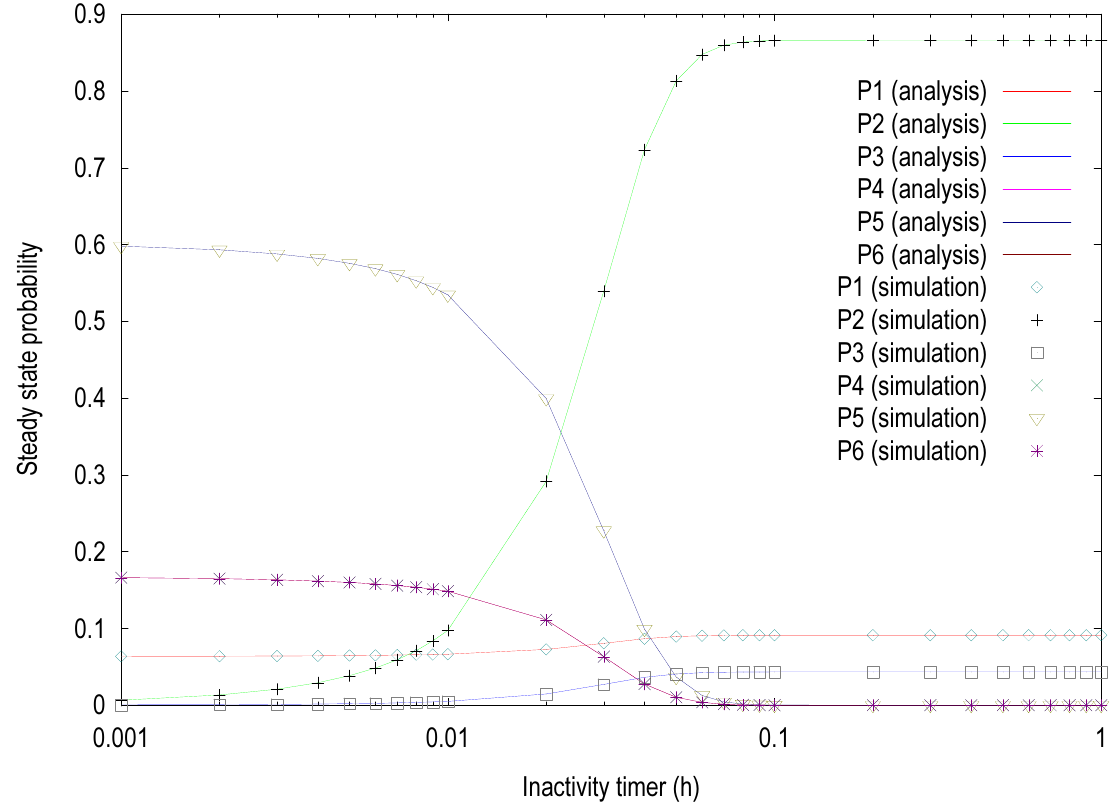
Steady-state probability by varying the session arrival rate (large values of T and T E W